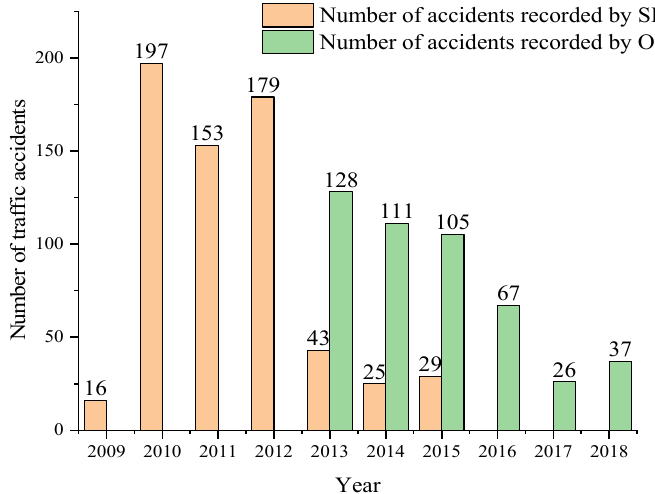
Figure 13. Number of traffic accidents per year for subcategory M1.